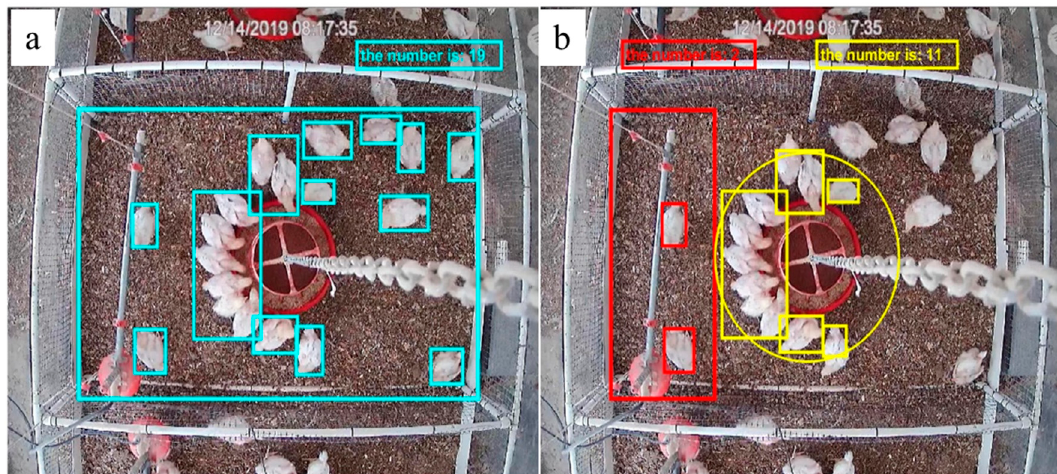
Figure 8. Broiler chicken distribution in feeding and drinking zones as identified by the BP model. ( a ) total chicken tracked and identified; ( b ) chicken distribution in drinking and feeding zones. The big red rectangle is the drinking zone, and the small red rectangles in this zone indicate the detected broiler chickens. The yellow circle is the feeding area, and the yellow rectangles in the zone indicate detected broiler chickens.